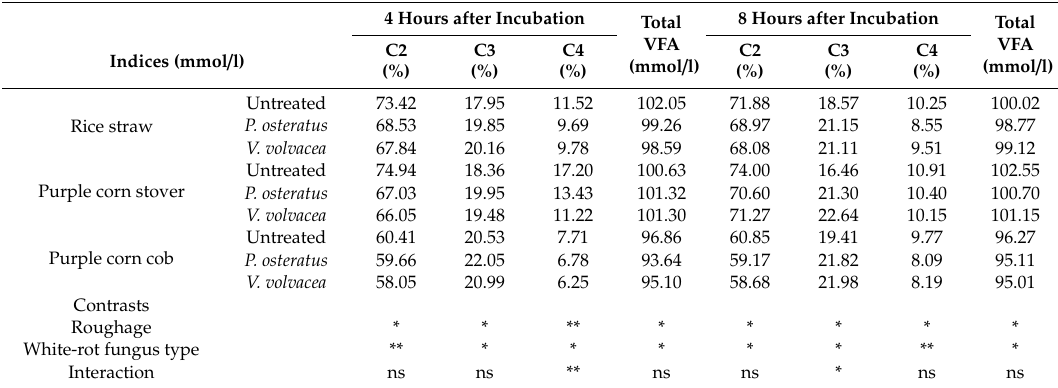
Table 5. E ff ect of roughage fermentation with white-rot fungus type on total volatile fatty acids (TVFA) and VFA profiles.